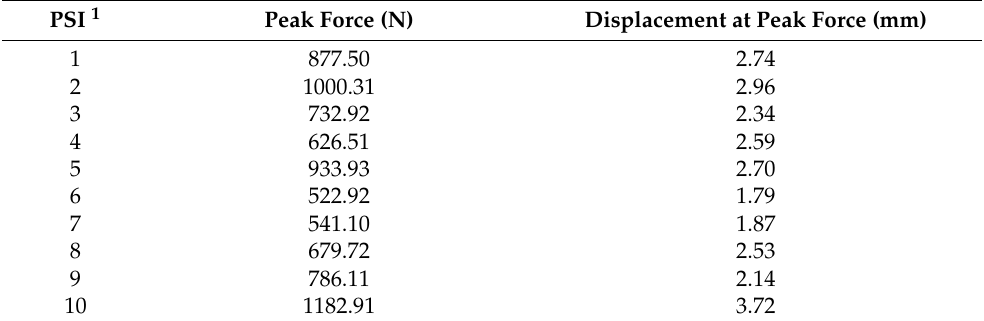
patient-specific cranial implants.